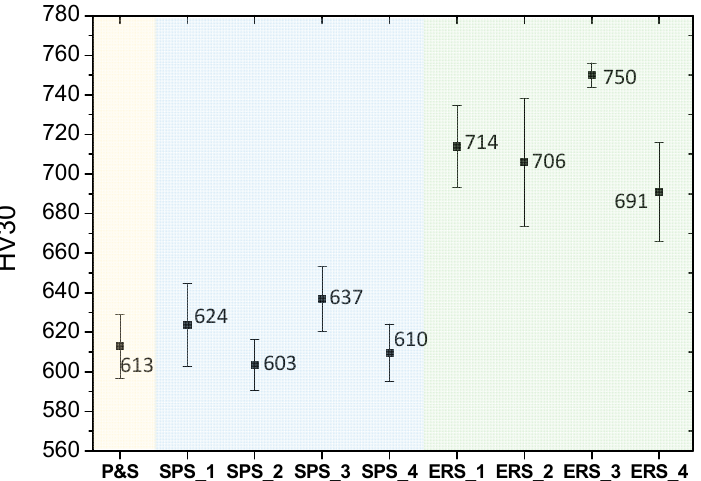
Figure 12. Hardness of samples sintered by P&S, SPS, and ERS.